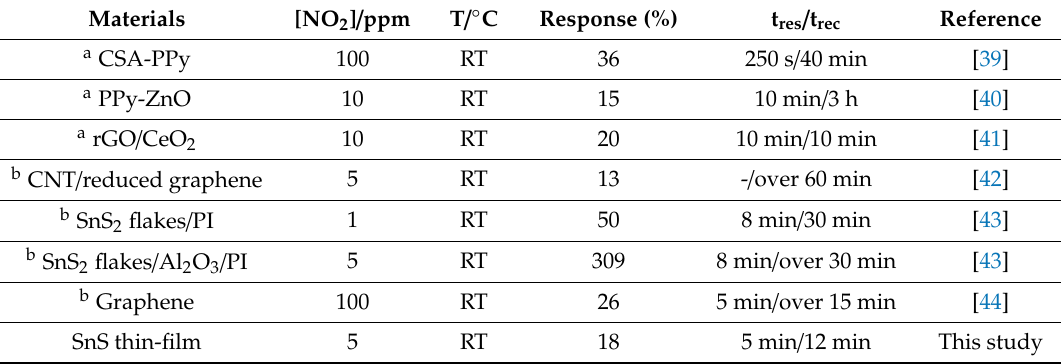
Table 4. Performances of several flexible sensors toward NO 2